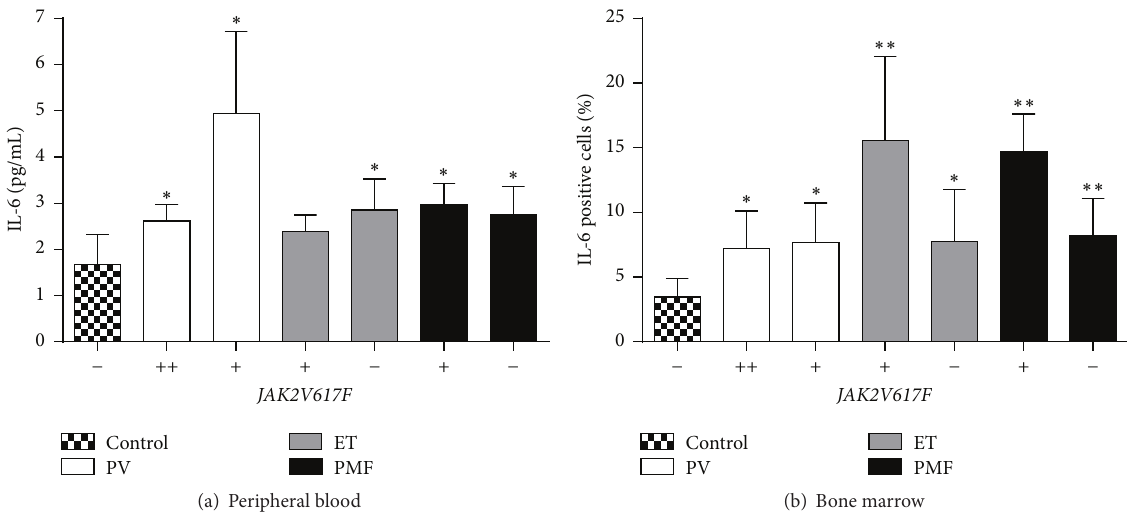
Figure 3: IL-6 levels in peripheral blood and bone marrow of MPNs in accordance with JAK2 V617F mutant allele burden. (a) IL-6 level in peripheral blood of patients with MPN determined by ELISA ( 𝑛 = 7 ). (b) IL-6 level in bone marrow of patients with MPN determined by immunohistochemistry. ( − ) no JAK2 V617F, (+) heterozygosity, and (++) homozygosity for JAK2 V617F mutation ( 𝑛 = 4 -5, plus control 𝑛 = 6 ). Values are mean ± SEM. ∗ 𝑝 < 0.05 , ∗∗ 𝑝 < 0.01 regarding MPNs versus Control.